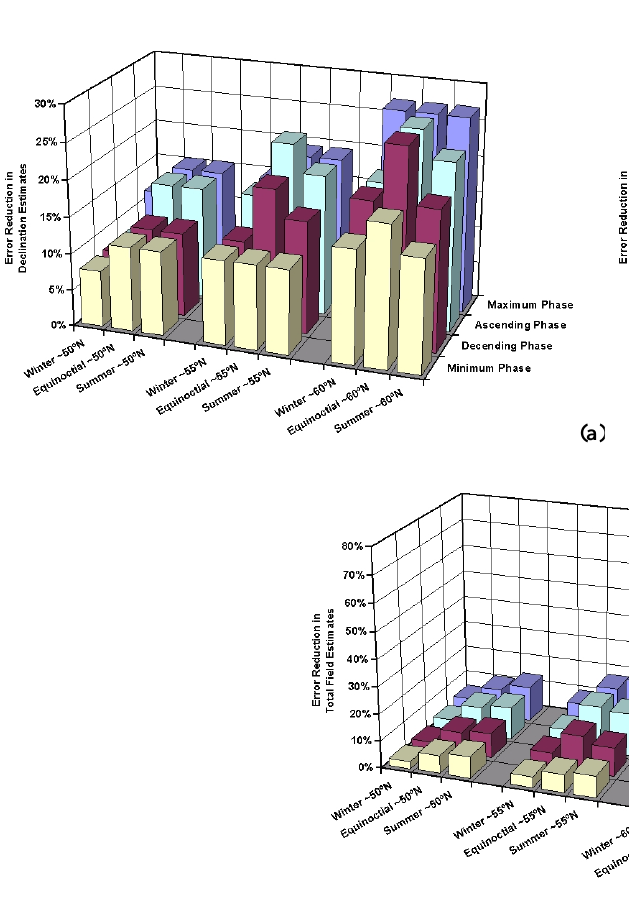
Fig. 2. The reduction in errors, as a percentage, in the estimates for declination (a) , inclination (b) and total field intensity (c) , when accounting for B d as well as B m + B c . The results shown are those obtained for the error reduction over 22 years (1983 to 2004) as a function of geomagnetic activity cycle (four phases as described in Fig. 3), latitude (three locations at approximately 50 ◦ , 55 ◦ and 60 ◦ N) and season (winter, summer and equinoctial).